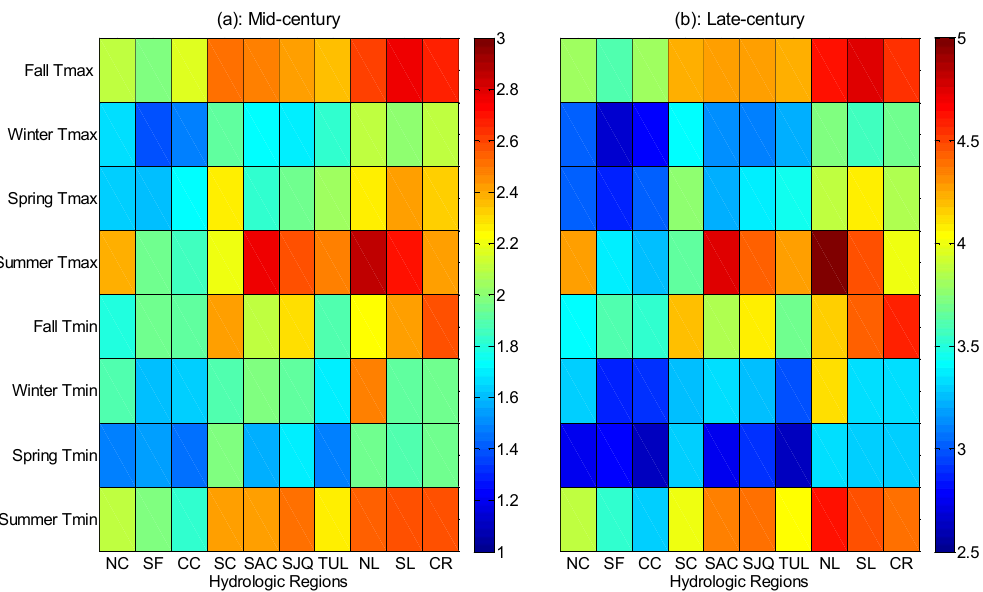
Figure 8. Differences (°C) between historical and mean (of all 20) projections on seasonal maximum temperature (Tmax) and minimum temperature (Tmin) in: ( a ) mid-century; and ( b ) late-century.